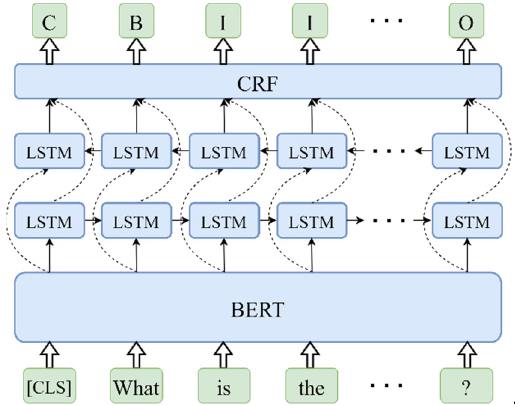
Figure 1. The architecture of BERT-BiLSTM-CRF model.